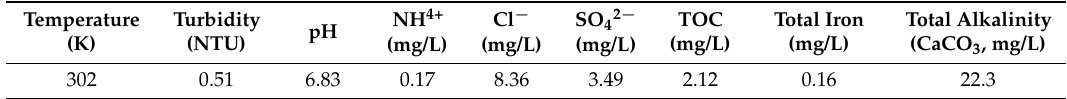
Table 5. Actual water quality after filtration.